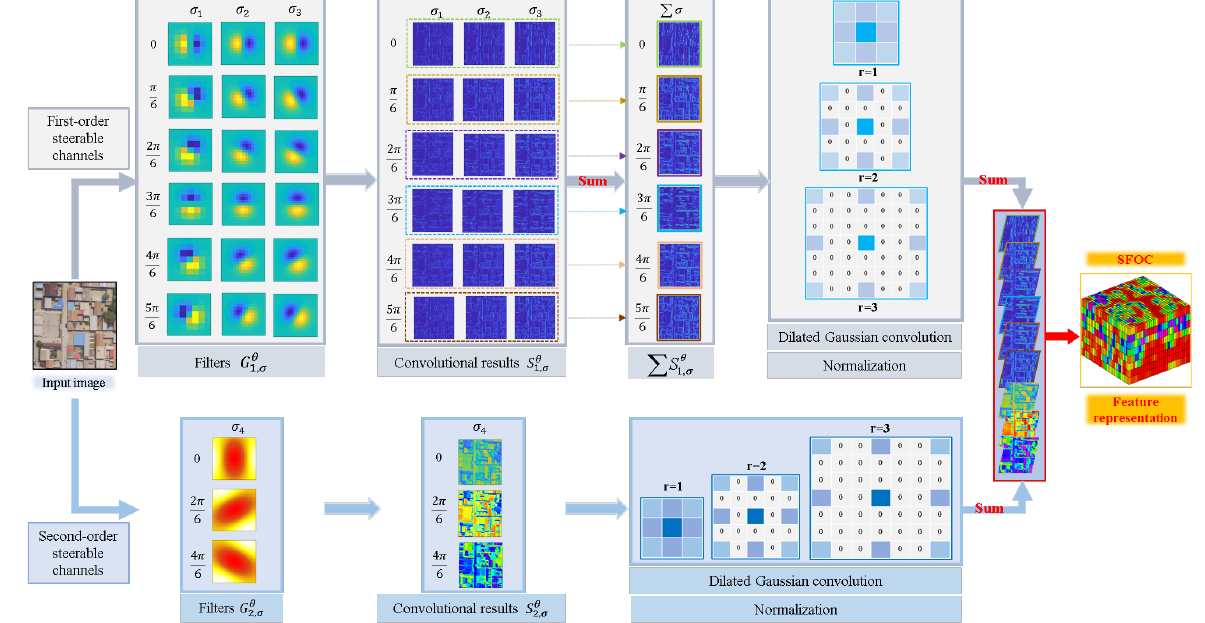
Figure 2. Construction flowchart of the proposed SFOC